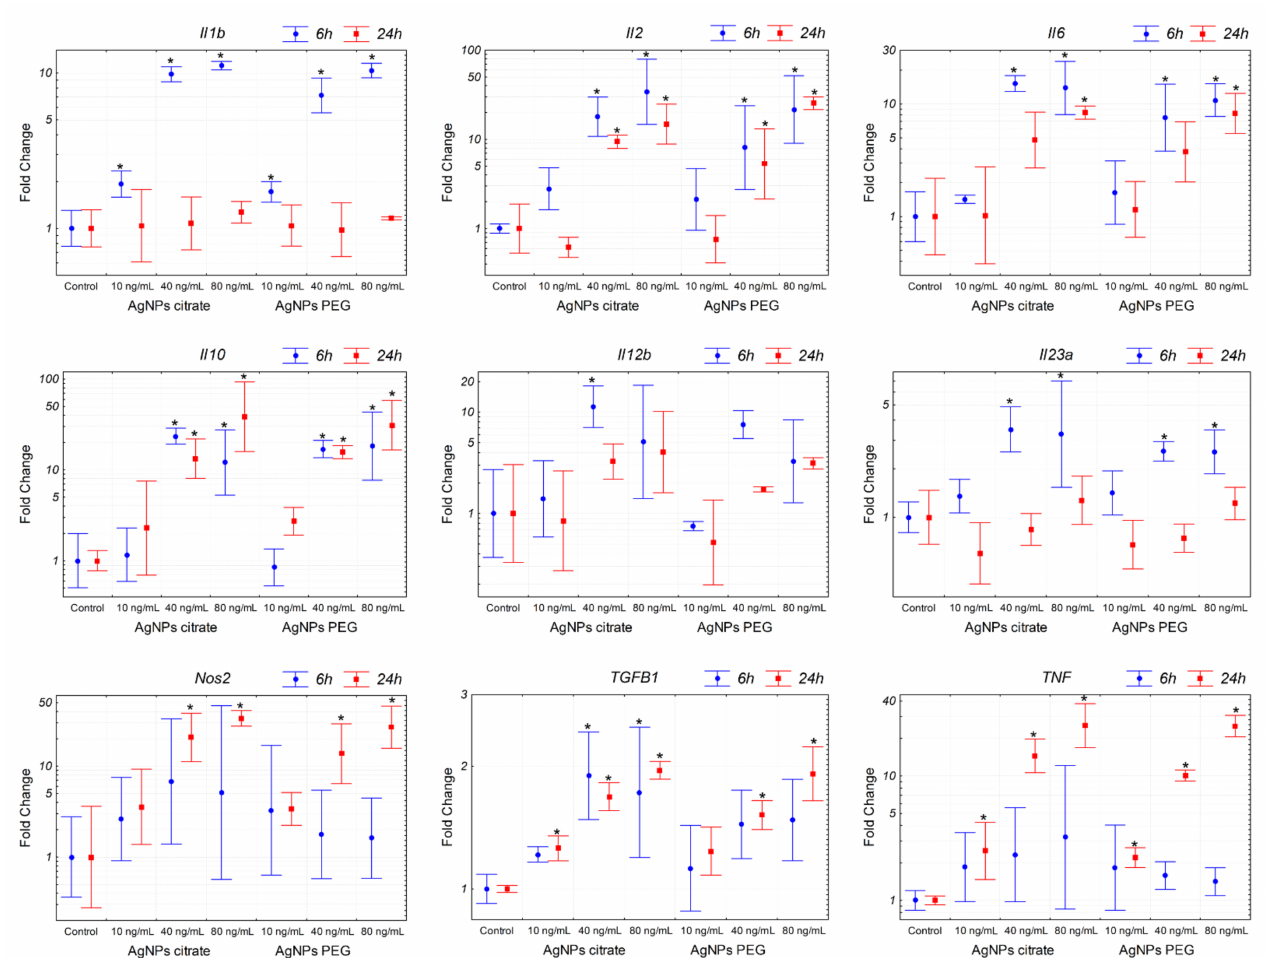
Figure 6. Expression of genes related to inflammation in 4T1 cells treated in vitro with citrate- or PEG- coated AgNPs for 6 or 24 h. Markers represent mean fold change values and whiskers represent the minimum and maximum fold change calculated from a standard deviation of ∆ Ct values. * p < 0.05 difference versus control group, n =